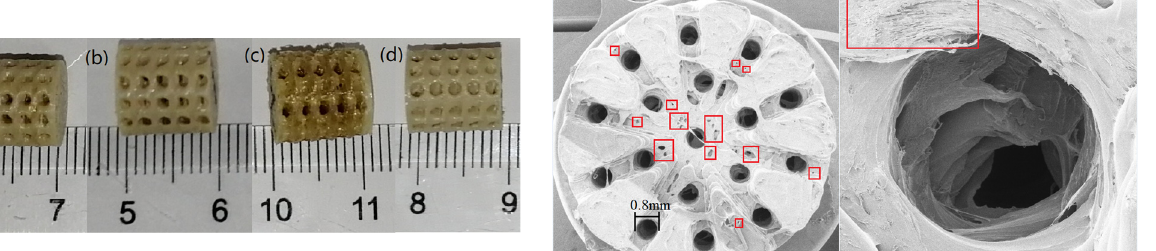
Figure 3: The PEEK scaffold in different processing condition ( the nozzle temperature, the printing speed, and the layer thickness ) : ( a ) 390°C, 20 mm/s, 0.08 mm; ( b ) 430°C, 20 mm/s, 0.12 mm; ( c ) 390°C, 30 mm/s, 0.1 mm; and ( d ) 430°C, 10 mm/s, 0.1 mm.